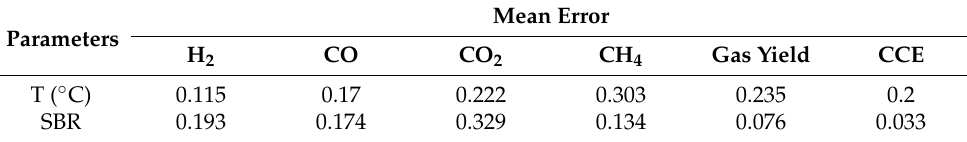
Table 6. Analysis of